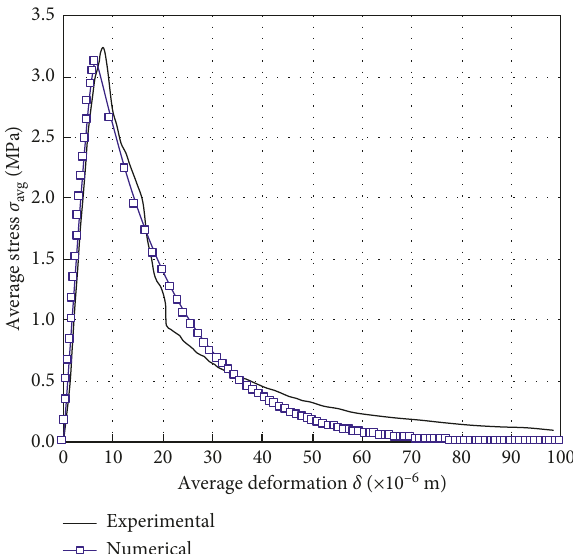
Figure 10: Average stress-deformation curves for the DEN concrete specimen.